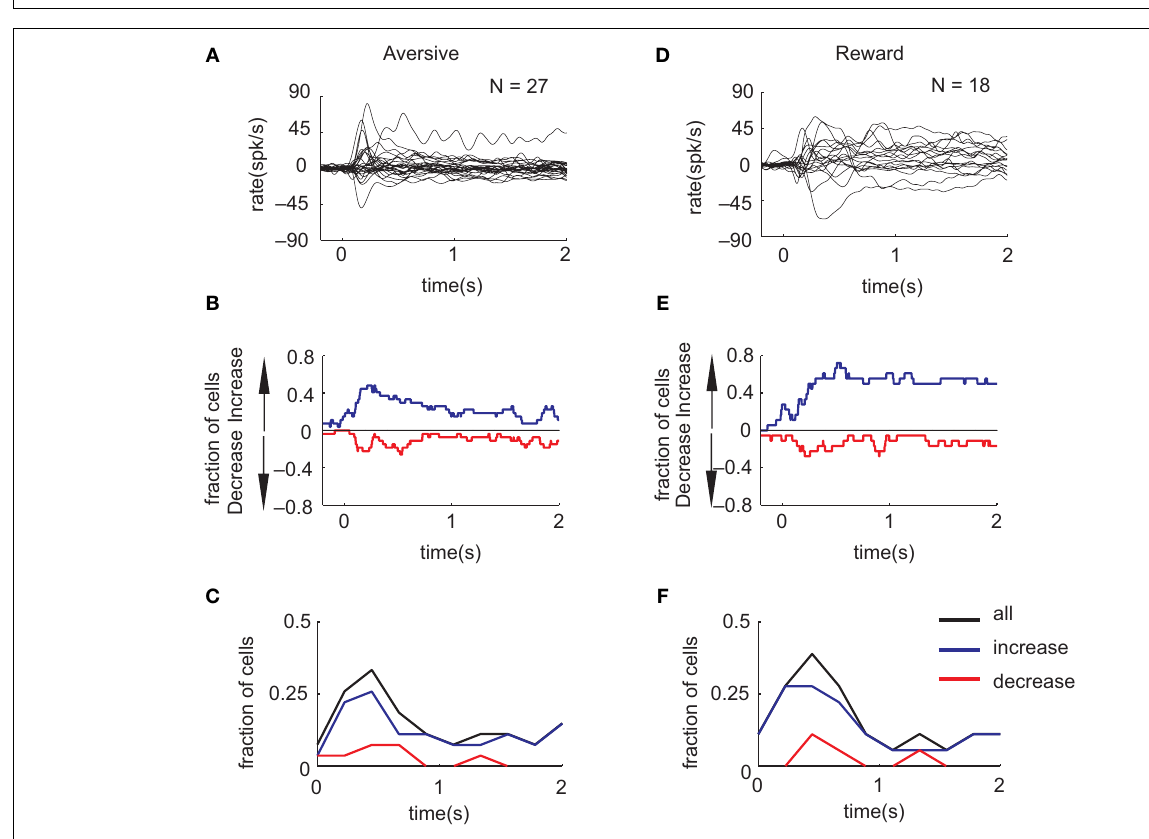
FIGURE 3 | Monkey’s behavior but not SNpr neural activity achieves new trials. The fi t values appear at the top of the fi gure; fi t values not similarity between responses to new and familiar cues – Population signifi cantly different from zero ( t -test, p > 0.05) are in gray. (B) Same as (A) for analysis. (A) Fraction of SNpr cells (red) and behavioral sessions (black) which the new reward cues. (C) The number of cells used in each bin for the analysis of differentiate between responses to a new aversive cue and familiar aversive fraction of cells. After the 60th bin (# new trials 60–79) there was a considerable + A cues. Data were fi tted to an exponential model: Y = A · exp( − X / T ); reduction in the number of recorded cells and hence we limited the analysis in 0 1 X = number of new trials, weighted according to the number of cells or sessions (A) and (B) to the fi rst 60 bins. Note that the increases in the number of cells are in each trial. T is the time constant of the exponential fi t in units of number of due to isolation of new cells during task